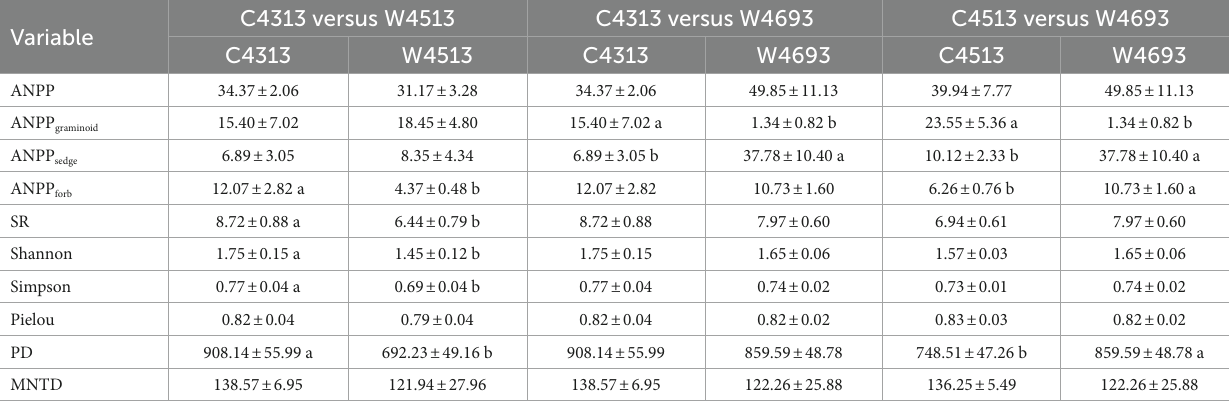
TABLE 1 Comparison of average ANPP, ANPP graminoid , ANPP sedge , ANPP forb , SR, Shannon, Simpson, Pielou, PD, and MNTD in 2011–2019 of the C4313 versus W4513, C4313 versus W4693, and C4513 versus W4693 based on a repeated ANOVA.